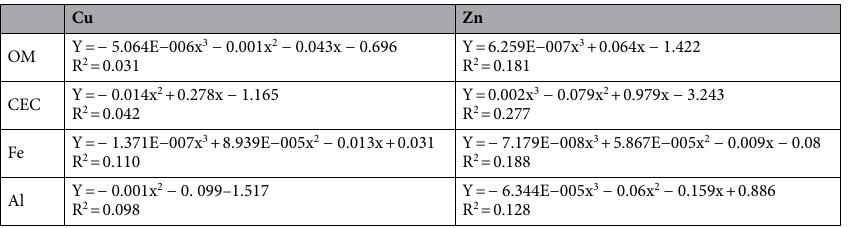
Table 10. Regression equations between sediment components and adsorption